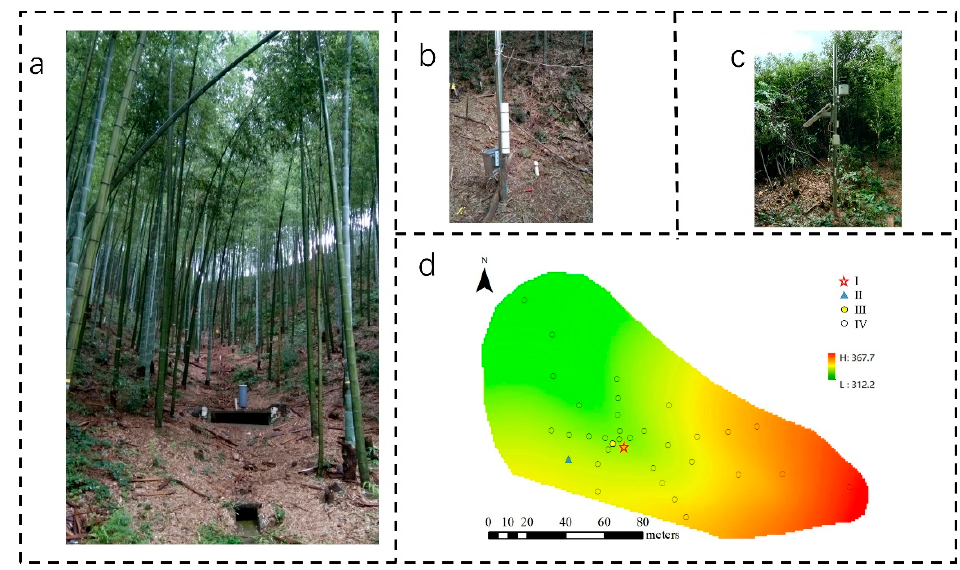
Figure 2. Location of the cosmic-ray neutron sensing probe and the experimental sampling design at Hemuqiao station. ( a ) View of the study site. ( b ) CRNP system. ( c ) Meteorological instrument. ( d ) Digital elevation map and sampling points of the study site, I: CRNP; II: Meteorological instrument; III: FDR auto soil moisture monitor; IV: Soil sampling points.